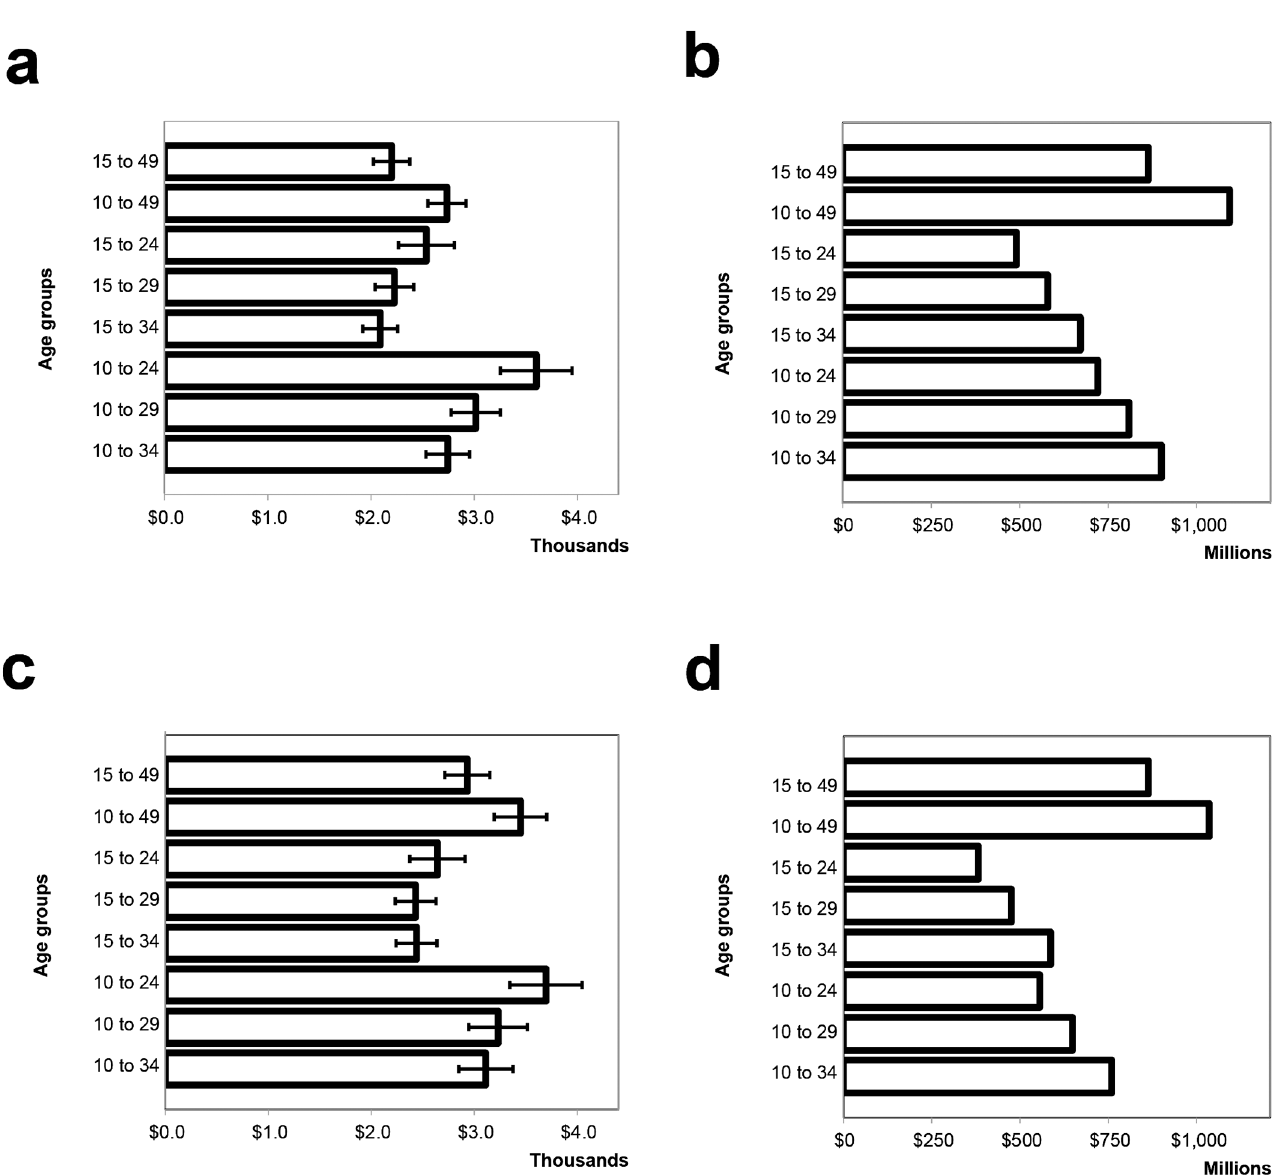
Fig 2. VMMC cost-effectiveness and program cost with and without increasing unit cost with client age. (a) discounted cost per HIV infection averted, 2014 – 2028, scenario 1: unit costs the same across all age groups; (b) discounted total cost of VMMC program, 2014 – 2028, scenario 1: unit costs the same across all age groups; (c) discounted cost per HIV infection averted, 2014 – 2028, scenario 2: increasing unit cost with increasing client age; (d) discounted total cost of VMMC program, 2014 – 2028, scenario 2: increasing unit cost with increasing client age. Each bar represents scale-up of VMMC among the indicated age group, compared with a reference case in which male circumcision prevalence is maintained at base levels from before the initiation of the VMMC program. Error bars represent uncertainty bounds as described in [11]. doi:10.1371/journal.pone.0157071.g002 PLOS ONE | DOI:10.1371/journal.pone.0157071 July 13,